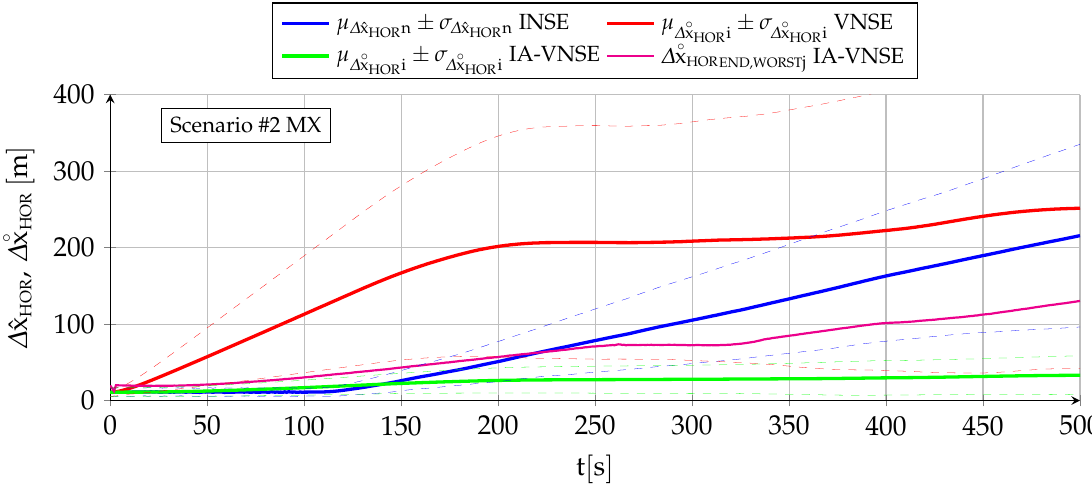
Figure 14. Horizontal position INSE, VNSE, and IA-VNSE for scenario #2 MX (100 runs).